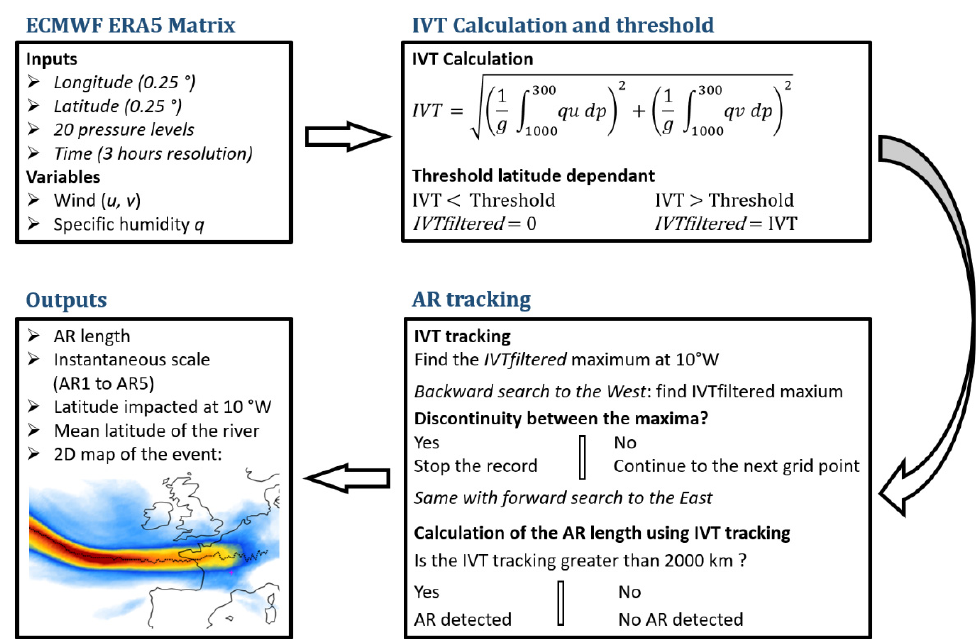
Figure 1. Schematic overview of ARiD. AR1 to AR5 refer to the recently created atmospheric river intensity and impact scale [33].